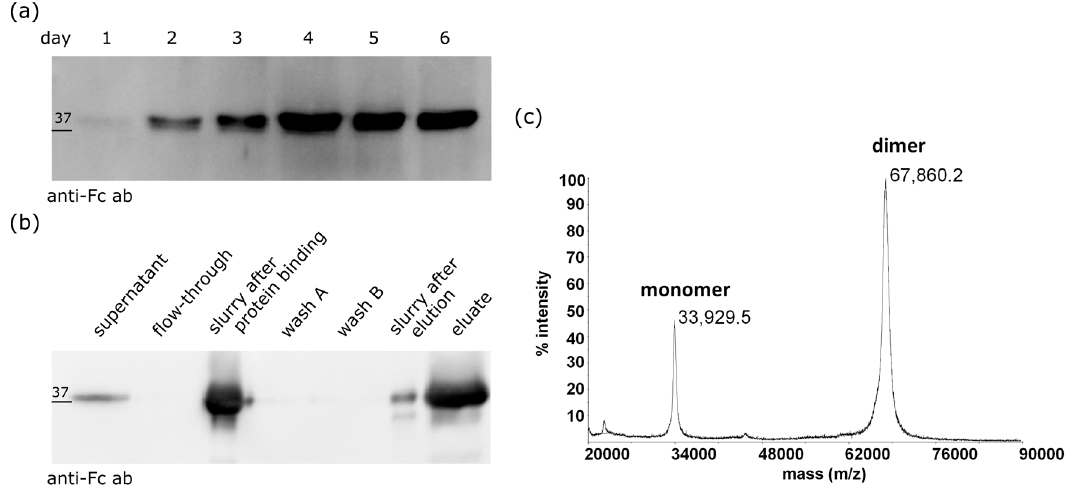
Figure 2. Expression and purification of Z HER2:2891 -Fc. ( a ) The levels of Z HER2:2891 -Fc in the CHO-S cells culture medium; ( b ) Western blot analysis of the purification of Z HER2:2891 -Fc; ( c ) The mass spectrum of the purified Z HER2:2891 -Fc.